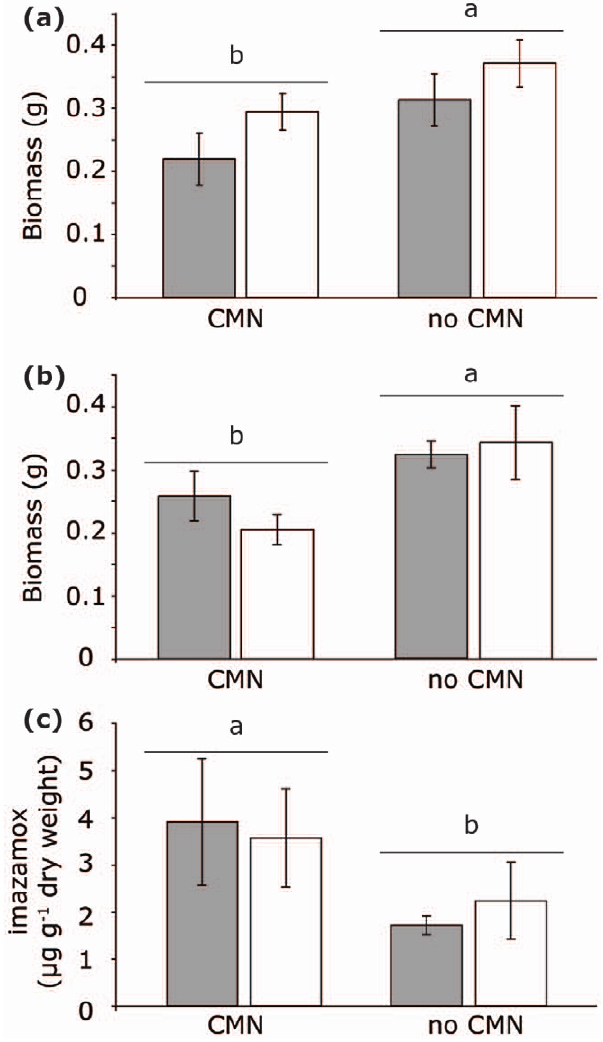
Figure 3. Results from Experiment 1 ± (means SE). Gray bars indicate bulk soil flow, and open bars indicate no bulk soil flow. Bars with different letters indicate significant differences at a =0.05 with a one-factor (CMN) model. (a) Above ground biomass at harvest 2 (N=5). (b) Above ground biomass at harvest 3 (N=5). (c) Imazamox concentrations in leaves at harvest 3 (N=4–5).